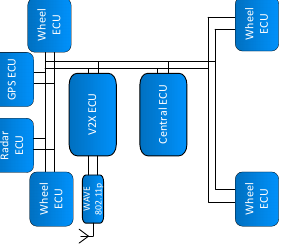
Figure 1: V2X-enabled E/E